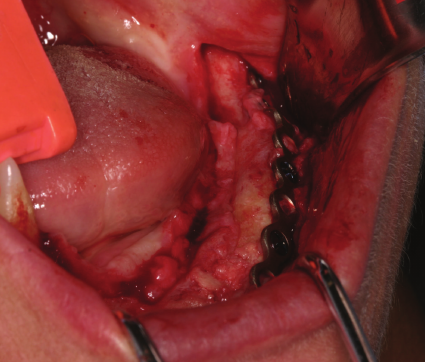
Figure 6: Reconstruction to increase the bone height to allow implant placement.